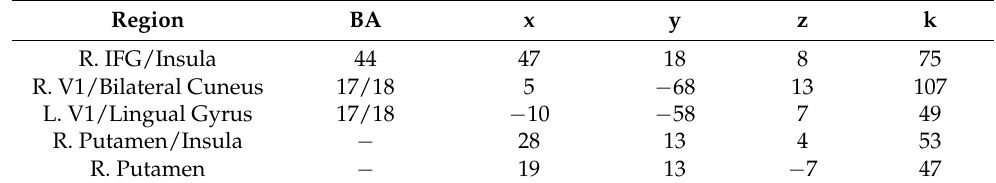
Table 1. Regions functionally connected to the entorhinal cortex during item memory for all participants. Region BA x y